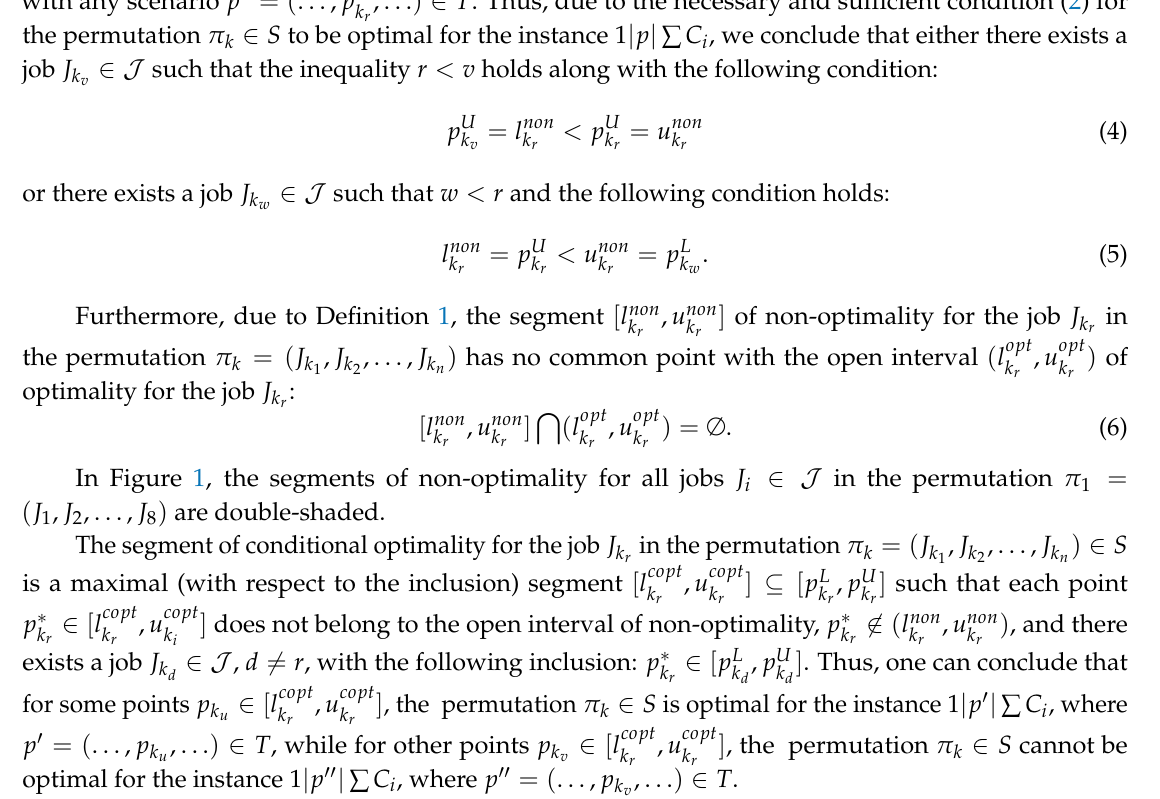
Figure 1. The segments of non-optimality (double-shaded) and the segments of conditional optimality (shaded) for the jobs J i ∈ J in the permutation π 1 = ( J 1 , J 2 , . . . , J 8 ) ∈ S